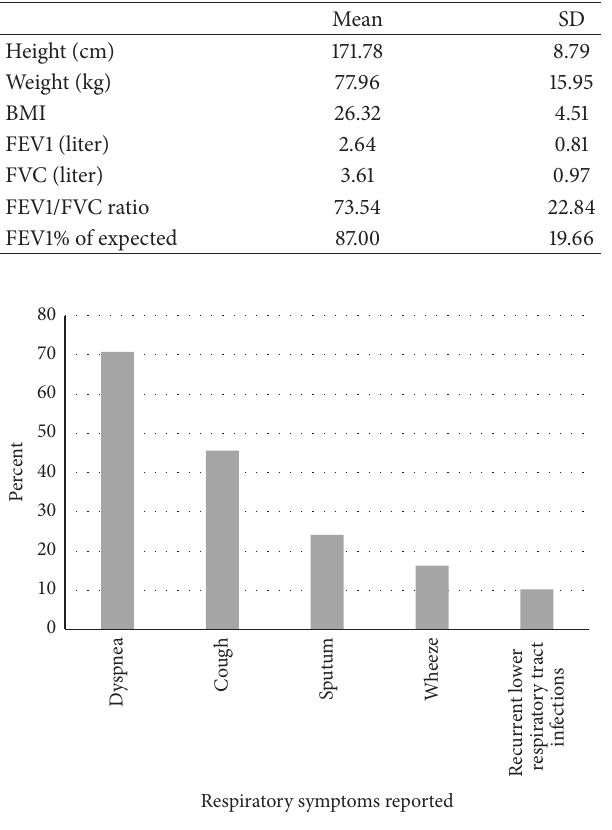
Table 1: Descriptive statistics and spirometry results ( 𝑁 = 1 ,499).